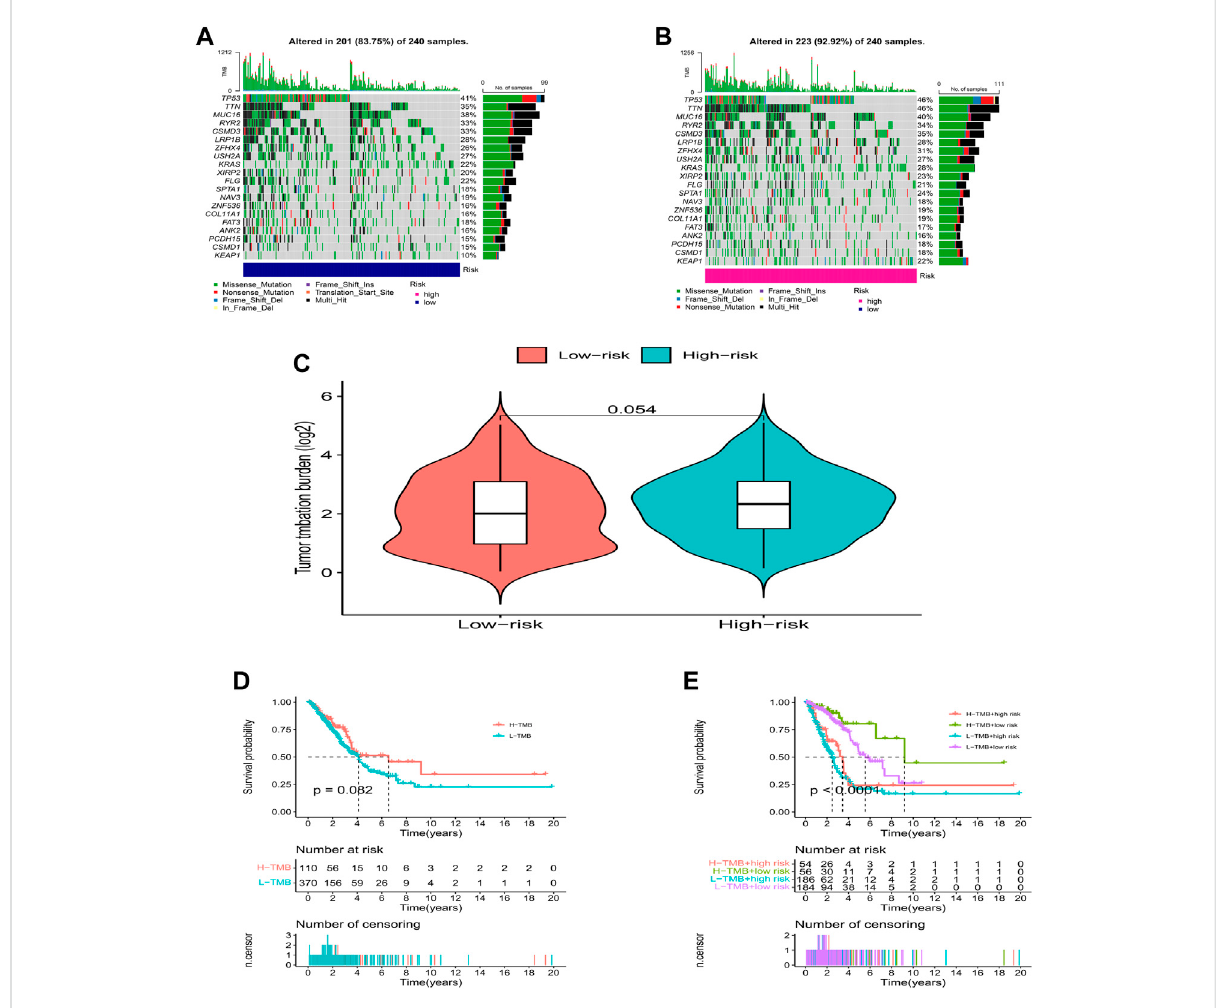
FIGURE 7 TMB analysis. (A,B) The waterfall plot of somatic mutation features established with high- and low-risk groups. (C) Tumor mutation burden in the high-risk and low-risk groups. (D,E) Kaplan-Meier curve of the OS among the high- and low- TMB